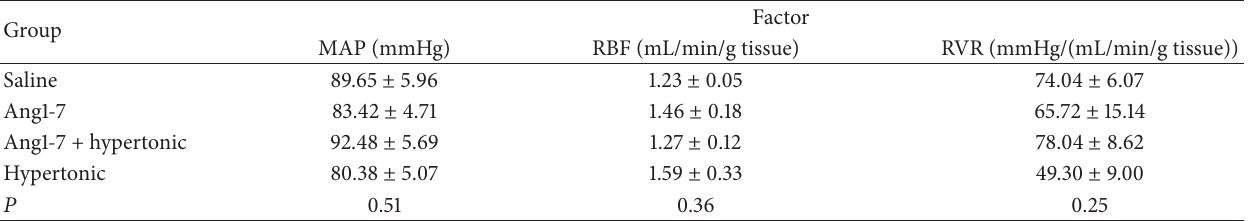
Table 1: Baseline hemodynamic parameters in 4 experimental groups.